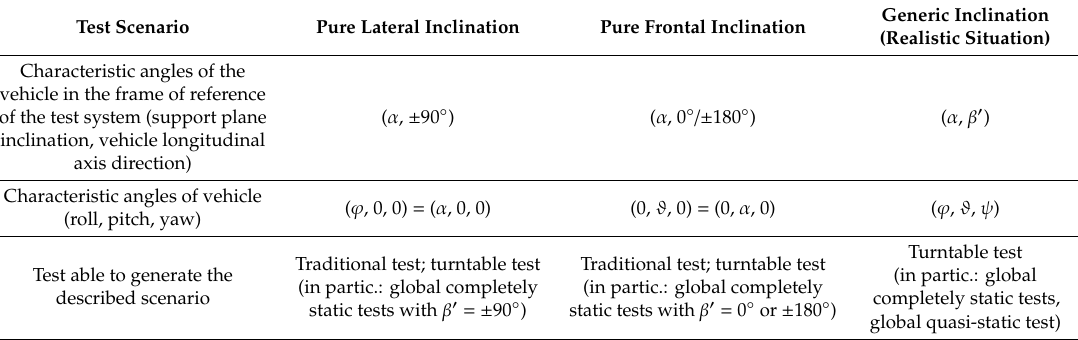
Table 1. possible scenarios that can be experimented by a vehicle placed on an inclinable platform (angles α and β (cid:48) (angles α and β′ ).